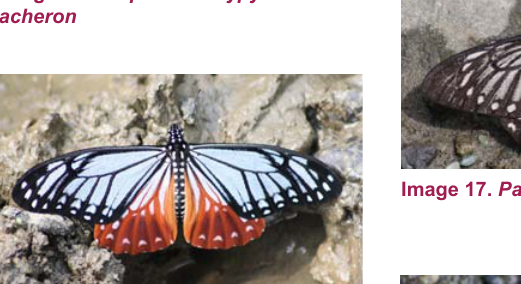
Image 13. Graphium eurypylus acheron